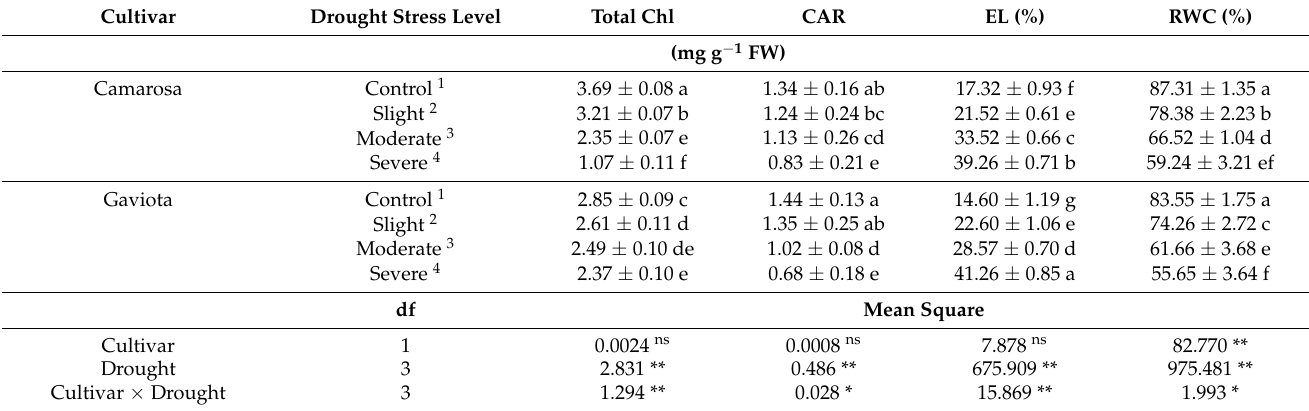
Table 1. Effects of different drought stress levels on photosynthetic pigments [total chlorophyll (Total Chl) and carotenoid (CAR) content], electrolyte leakage (EL), and relative water content (RWC) in Camarosa and Gaviota strawberry